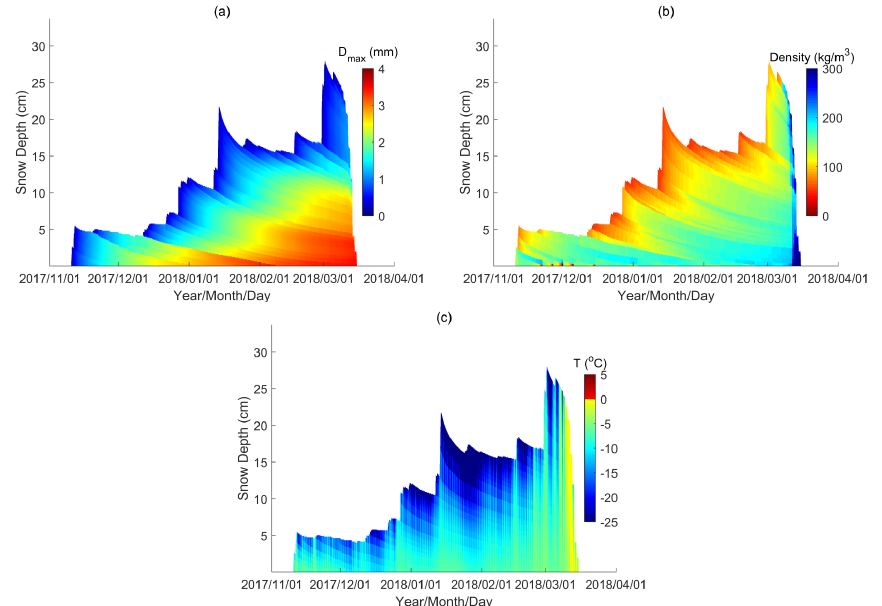
Figure 1. Time series change in snow depth, snow stratigraphy, and snow properties in the Altay dataset: ( a ) layered geometric grain size (D max ); ( b ) layered snow density; and ( c ) layered physical temperature (T).